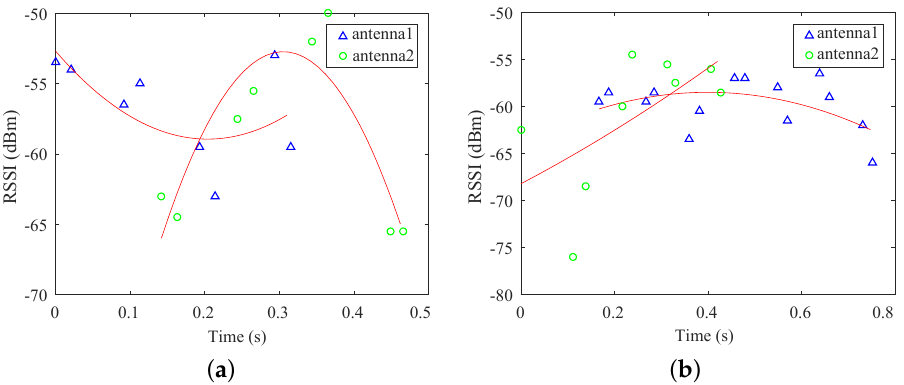
Figure 6. RSSI values collected from a running tagged person: ( a ) moving in; ( b ) moving